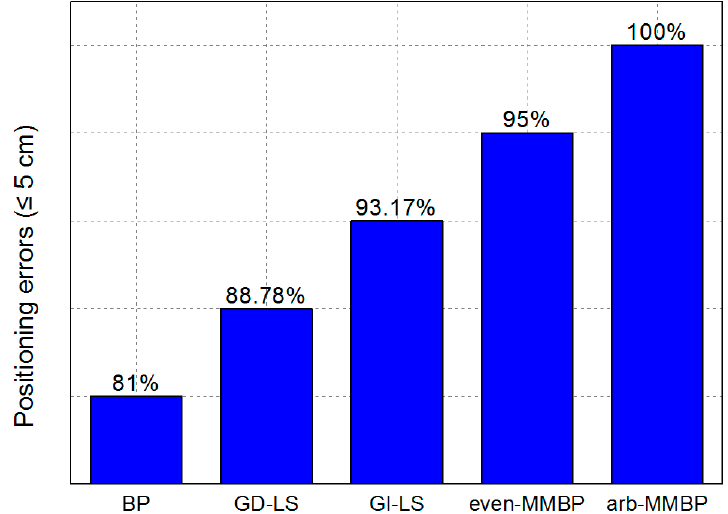
Figure 18. Probabilities of positioning errors less than 5 cm with different algorithms.